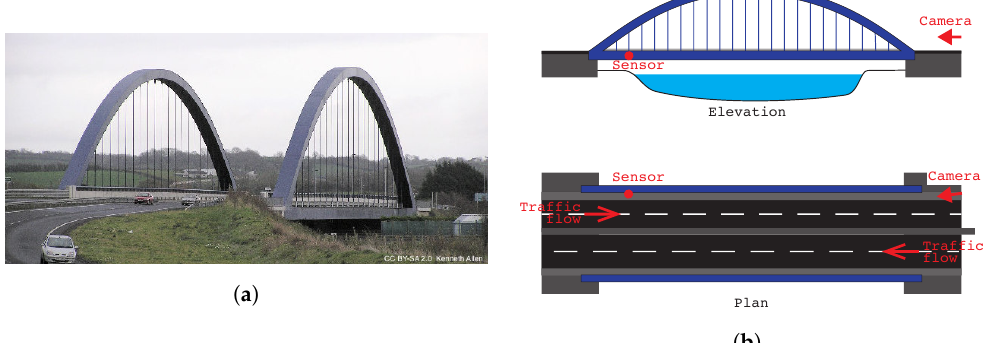
Figure 17. ( a ) Photograph of bridge from the western aspect and ( b ) test setup site elevation and plan.